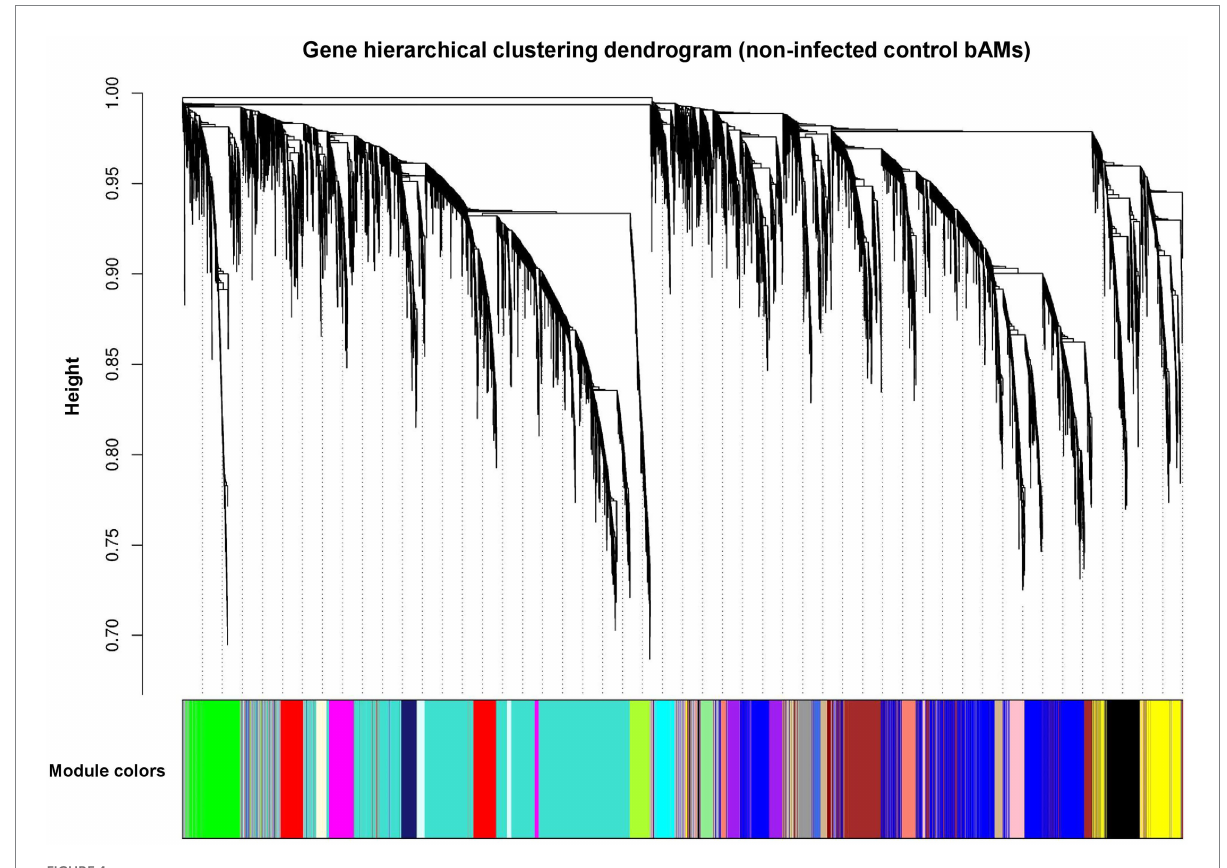
FIGURE 4 Gene hierarchical clustering dendrogram of detected modules across all samples. A total of 21 modules in different sizes were identified based on the TOM dissimilarity (1-TOM) in the non-infected control bAM samples as reference set through hierarchical clustering analysis and dynamic hybrid tree cutting algorithms. The x -axis represents the genes and the y -axis represents the co-expression distance. The branches indicate the modules, and each module was labeled with a unique color. The gray module including 576 genes indicate uncorrelated